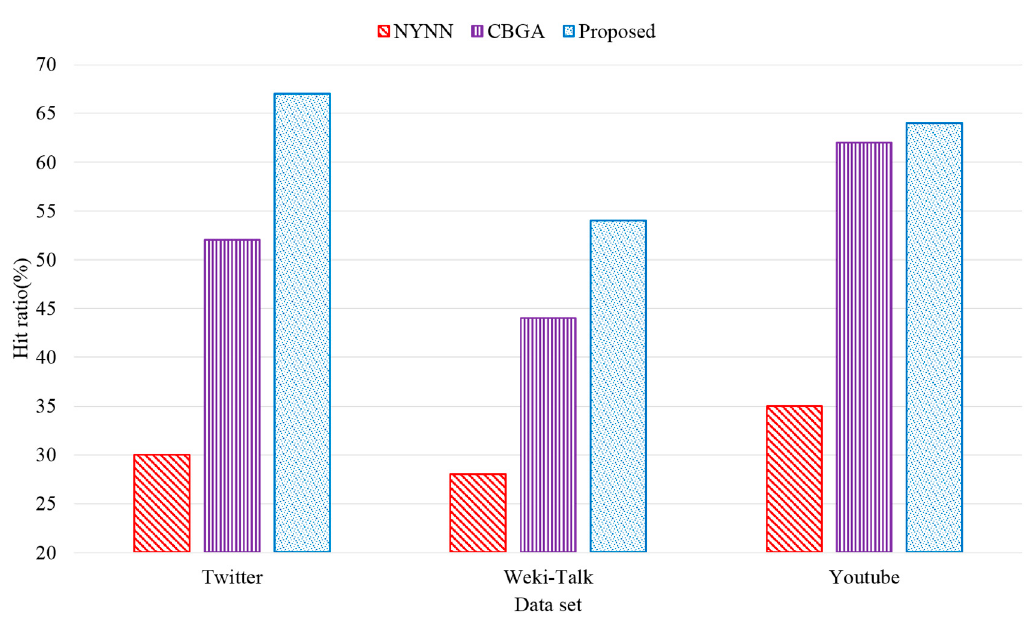
Figure 11. Hit ratio on each of the datasets.